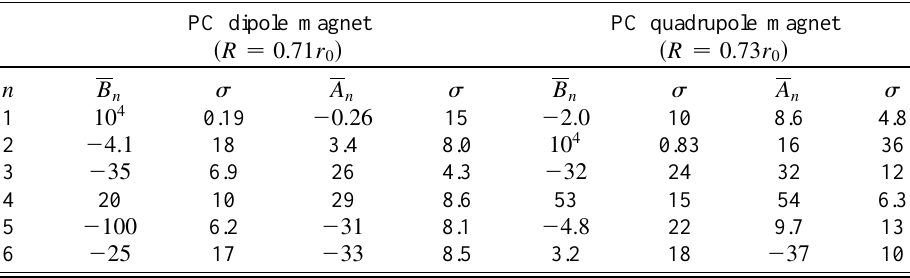
TABLE II. Average normal ( B n ) and skew ( A n ) integrated multipole components, and asso- ciated errors, of PC dipoles and quadrupoles in UMER.